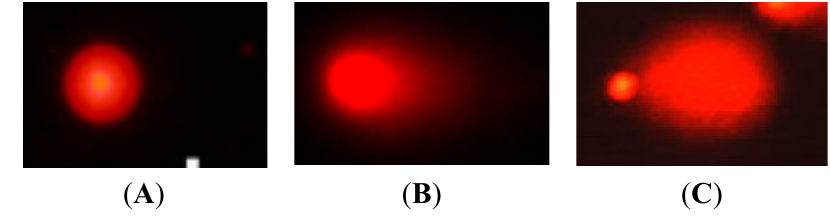
Figure 1. Comparison of control, comet, and apoptotic cells based on fluorescence microscopy [( A ): Normal cell, a round cell without a tail; ( B ): Comet cell, a cell that contains a tail and a head like a comet; and ( C ): Apoptotic cell, a cell with a large tail and a small head)].